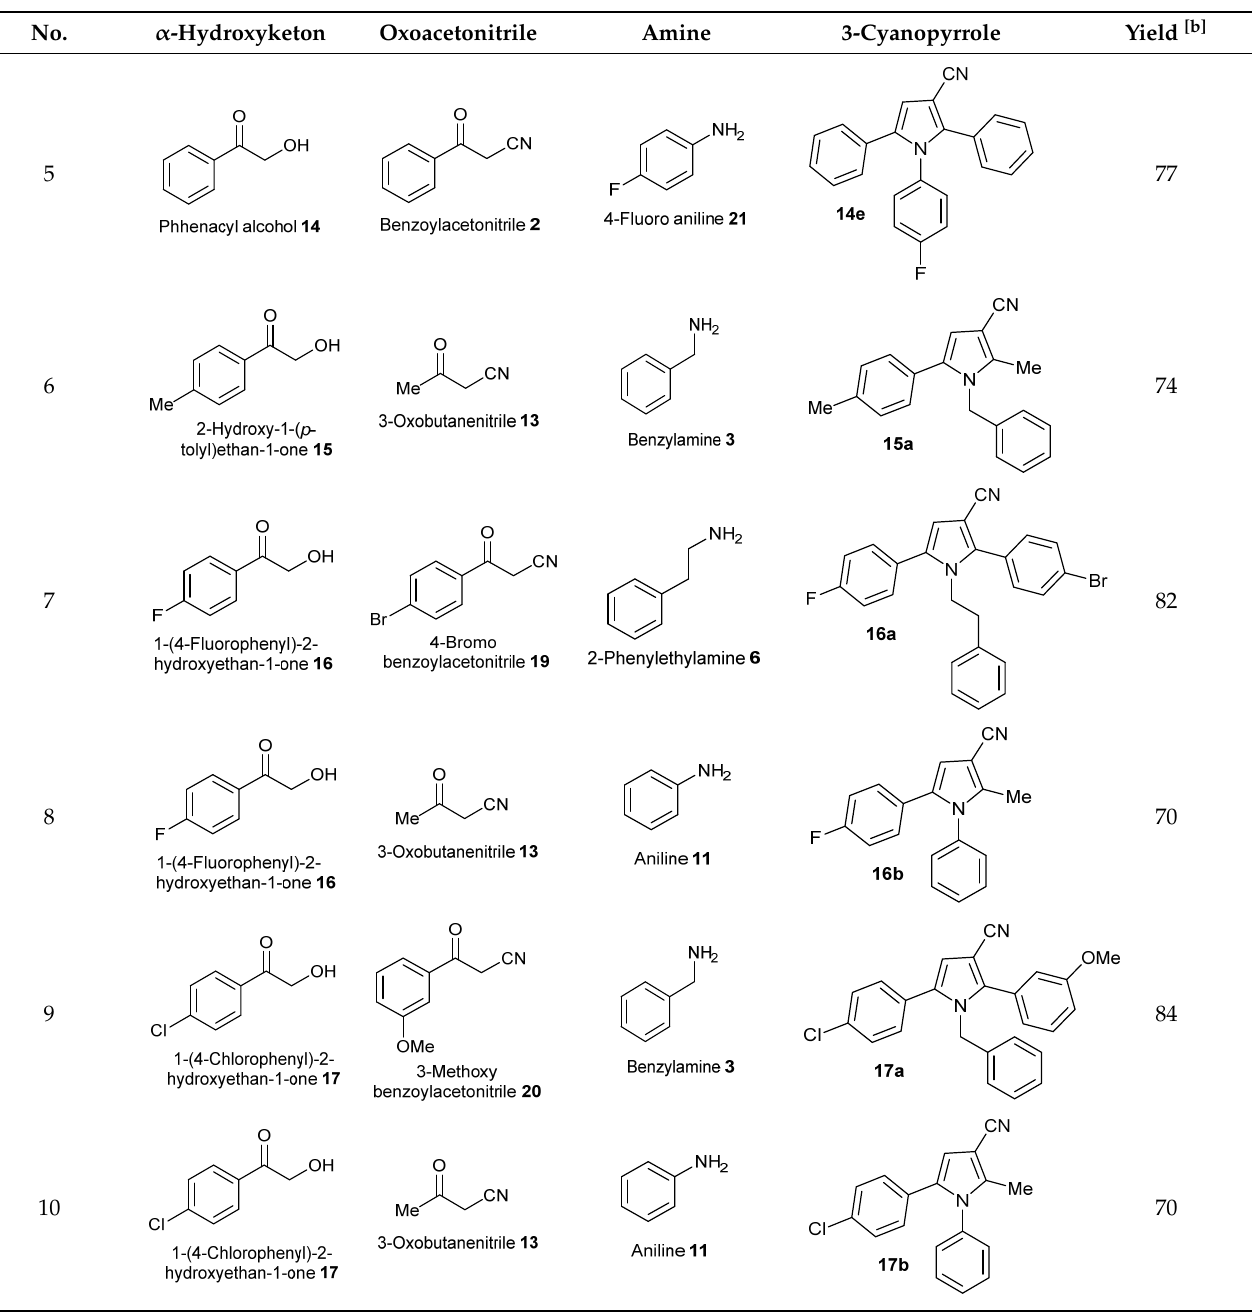
Table 3. The substrate scope of the AcOH-catalyzed three-component reaction between phenacyl alcohols 14 – 17 , oxoacetonitriles 2 , 13 , and 18 – 20 , and primary amines 3 , 5 , 6 , 10 , 11 , and 21 for the selective synthesis of 3-cyanopyrroles 14a – e , 15a , 16a – b , and 17a – b . [a].